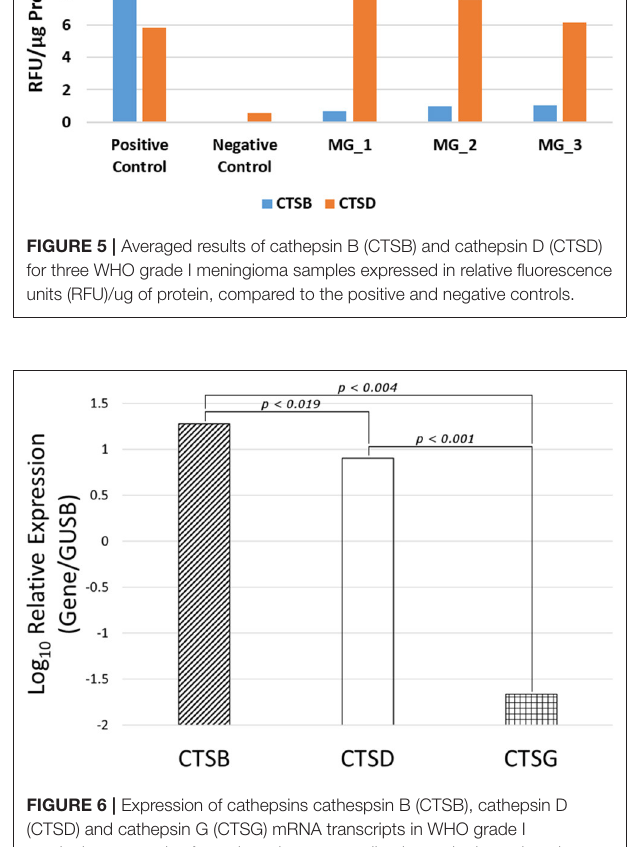
Supplementary Figure 1 | Representative 3,3-diaminobenzidine (DAB) immunohistochemical (IHC)-stained sections of positive human control tissues: placenta tissue for cathepsin B (A) , breast tissue for cathepsin D (B), and splenic lymphoma for cathepsin G (C) . A representative negative control section of WHO grade I meningioma tissue using a matched isotype control for both mouse and rabbit primary antibodies showed minimal staining (D) .